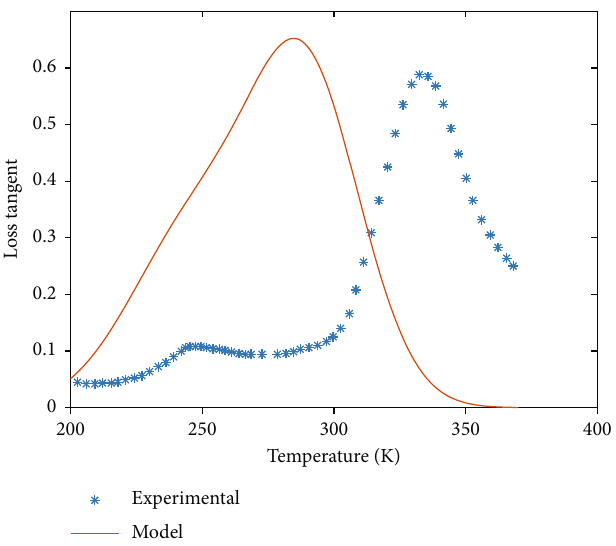
Figure 7: Prediction results for the 10Hz loss tangent.